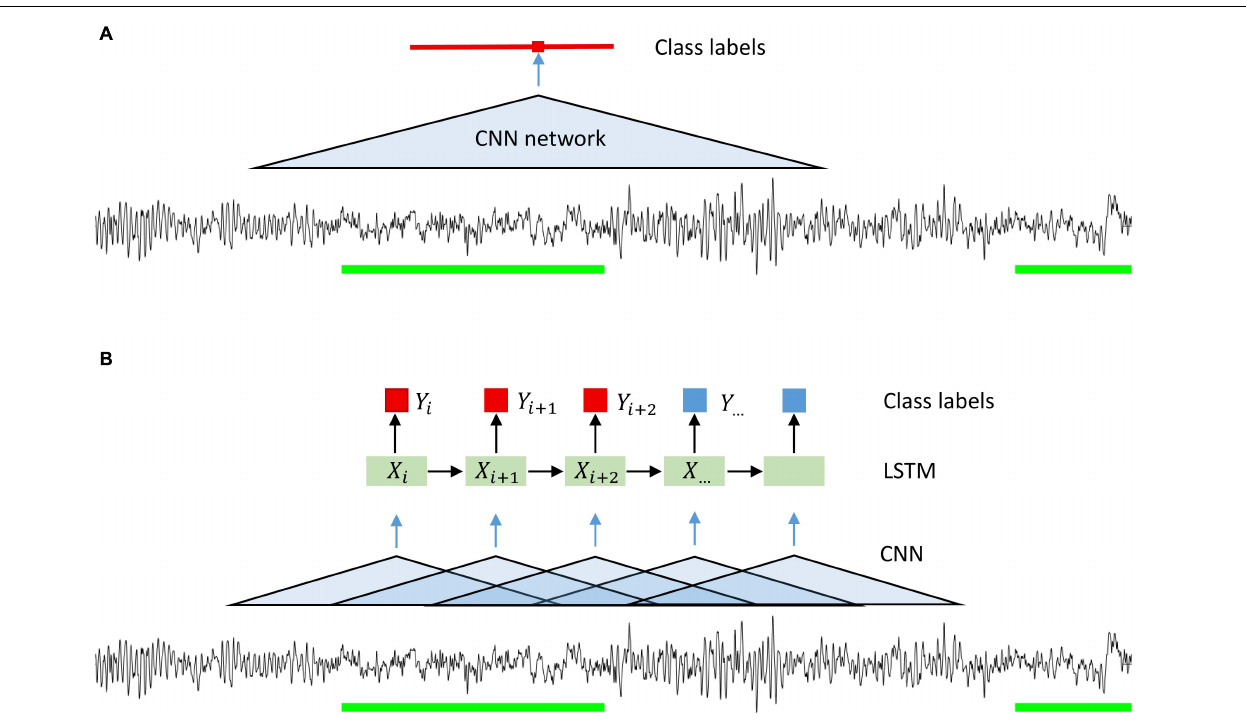
FIGURE 1 | Illustration of the idea behind the segmentation (classification) with a CNN (A) and CNN-LSTM (B) network. A sliding window was used in the case of CNN only networks. Microsleep episodes were inferred corresponding to the middle of the window on every step (sampling resolution). In case of CNN-LSTM network a sequence of overlapping windows (classified by a CNN) with the stride of 0.25 s inferring microsleep corresponding to the middle window in the sequence (LSTM classification). Thus, the resulting resolution of the detection was 0.25 s. Green bars: scored MSEs; red bar in (A) classified MSE; red and blue squares in (B) classification of a sample or